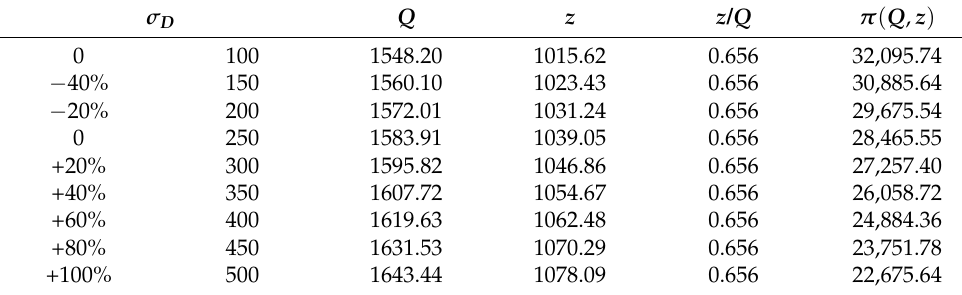
Table 5. The results for the various standard deviations of demand σ D